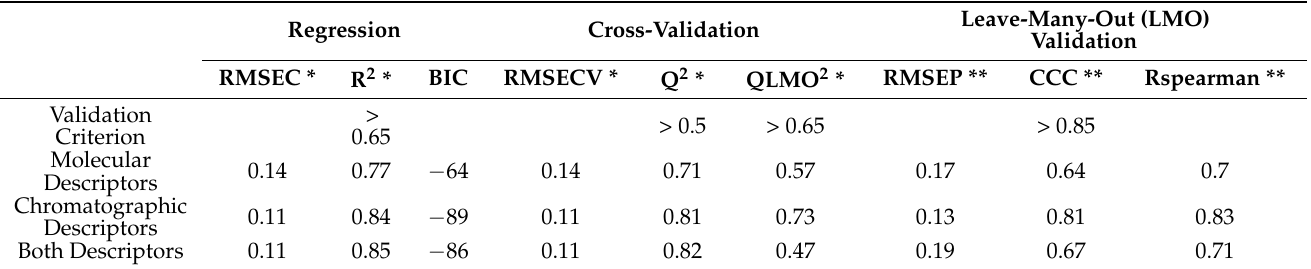
determined with observed and predicted CI calculated with test data set 1, 2, and 3.